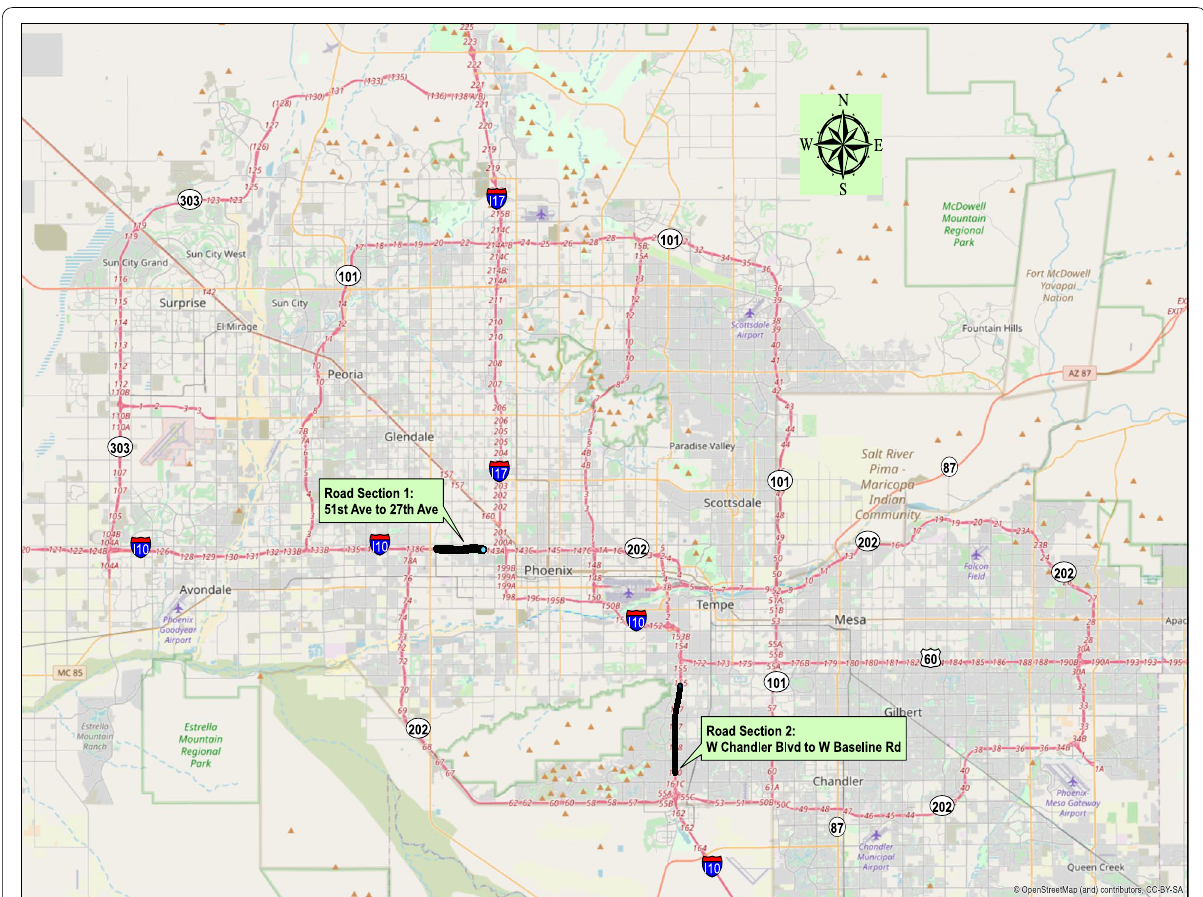
Fig. 1 Road sections in pavement condition surveys on the I‑10 corridor in Phoenix, AZ. Source: https:// cdn. arcgis. com/ shari ng/ rest/ conte nt/